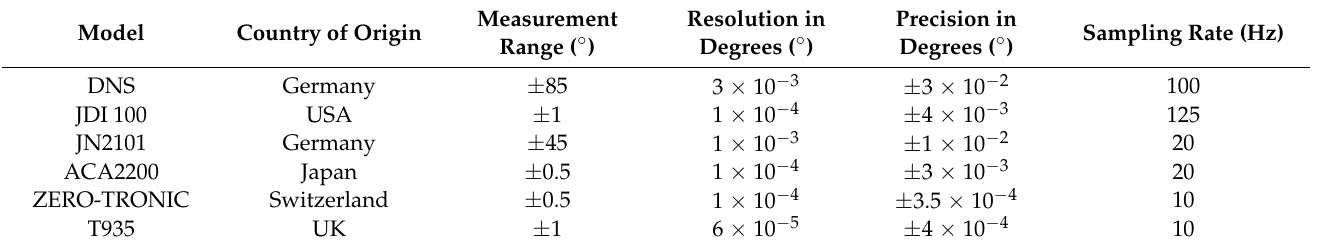
Table 1. Technical specifications of commercially available